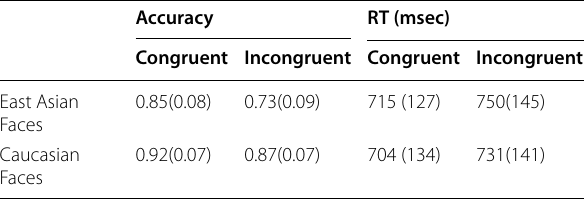
Table 2 Group-level performance in the face composite task in Experiment